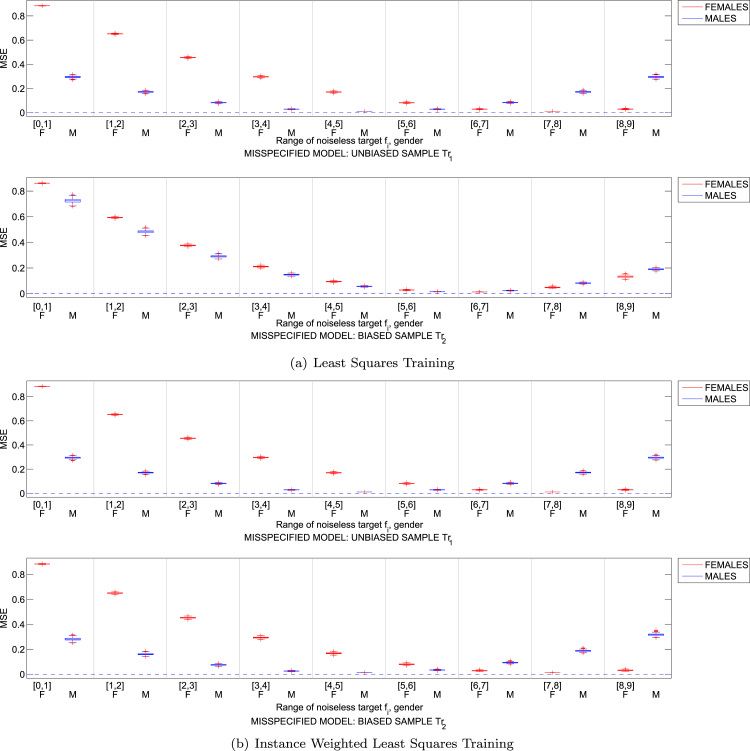
Results using least squares training are shown in (a), while (b) shows results using Instance Weighted least squares. In both figures, the top row shows the MSE as the value of the noiseless target fi changes, for each gender, when training using the unbiased sample Tr1 and a misspecified model. The bottom row in each figure shows the corresponding boxplot when using biased sample Tr2.